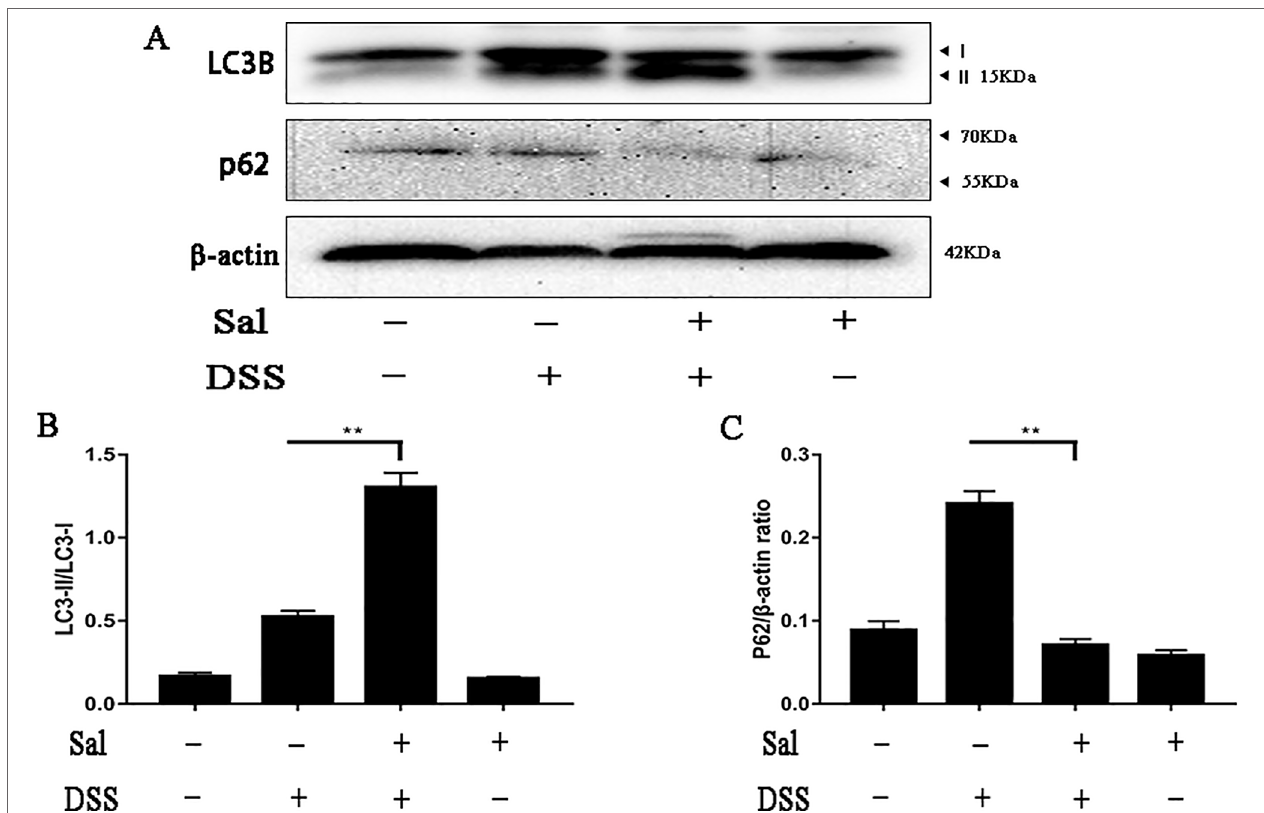
FIgURe 5 | Salidroside regulated the disordered autophagy situation in dextran sulfate sodium-treated mice. (A) Protein levels of LC3 and p62 in the colonic tissue were analyzed by western blot. (B, C) The relative protein expression of LC3 and p62 were normalized to β-actin. Data were repeated in three independent experiments. (**) p <